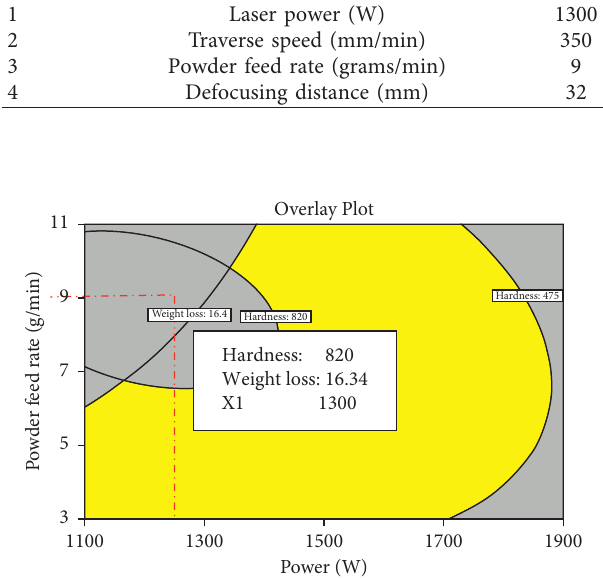
Figure 8: Graphical optimization plot shows the response of optimized process parameters for minimum weight loss and maximum